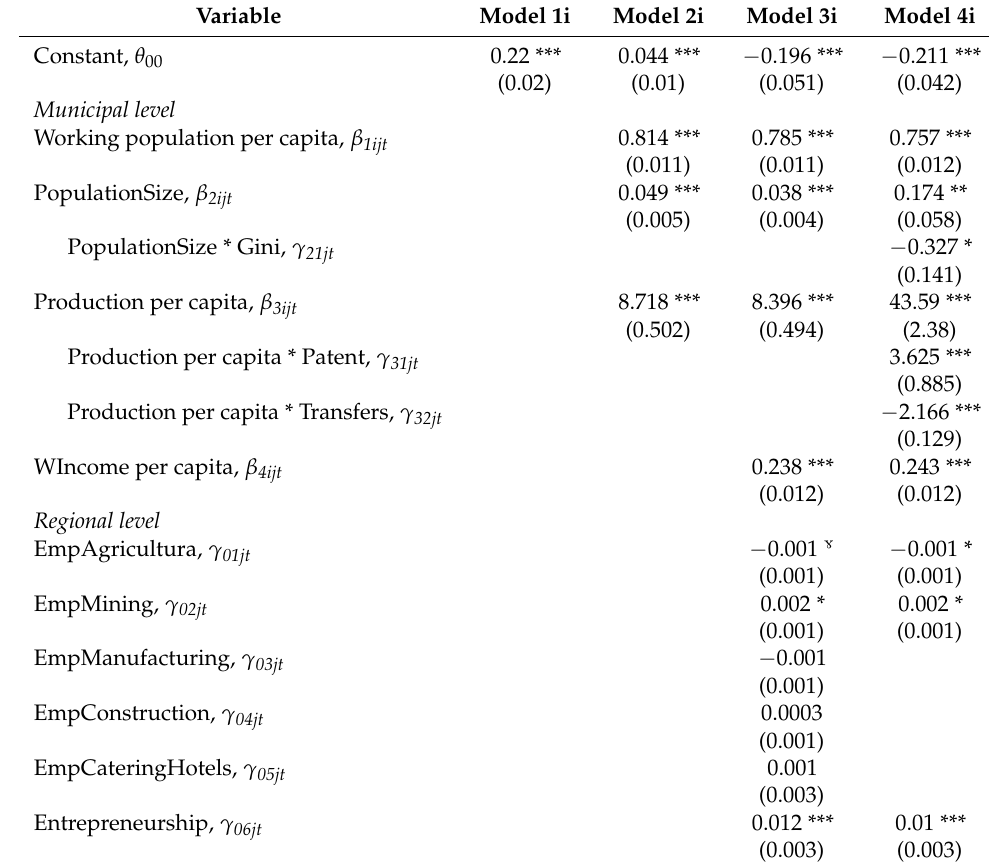
Table 3. Modelling results (dependent variable: Income per